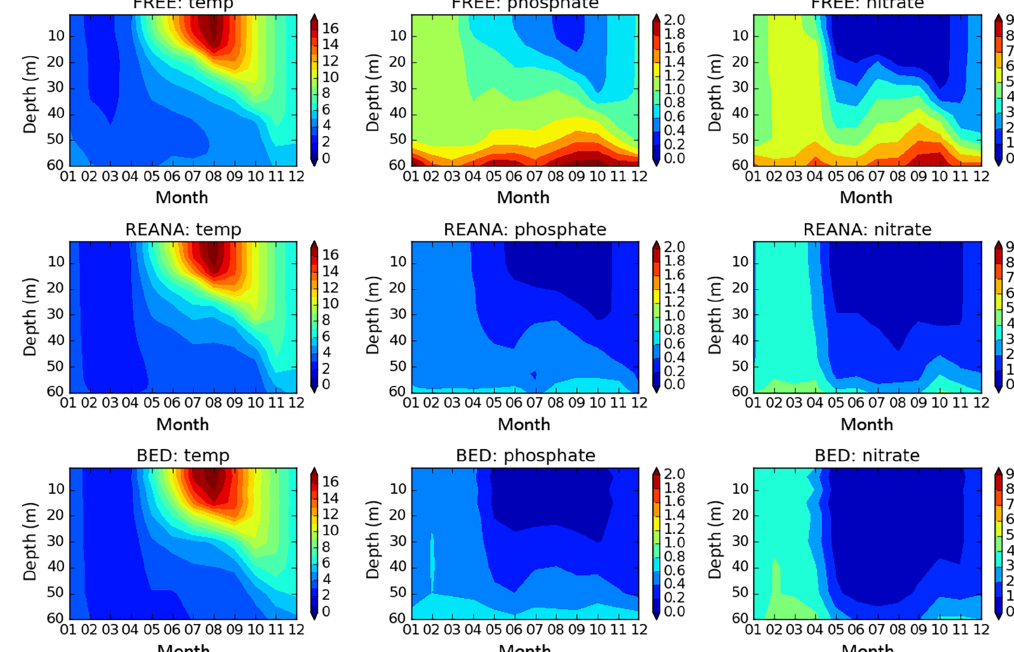
Figure 5. The seasonal cycle of monthly average (1970–1999) temperature ( ◦ C), phosphate concentration (mmolm − 3 ) , and nitrate concen- tration (mmolm − 3 ) at BY15 for FREE (row 1), REANA (row 2) and BED data (row 3),